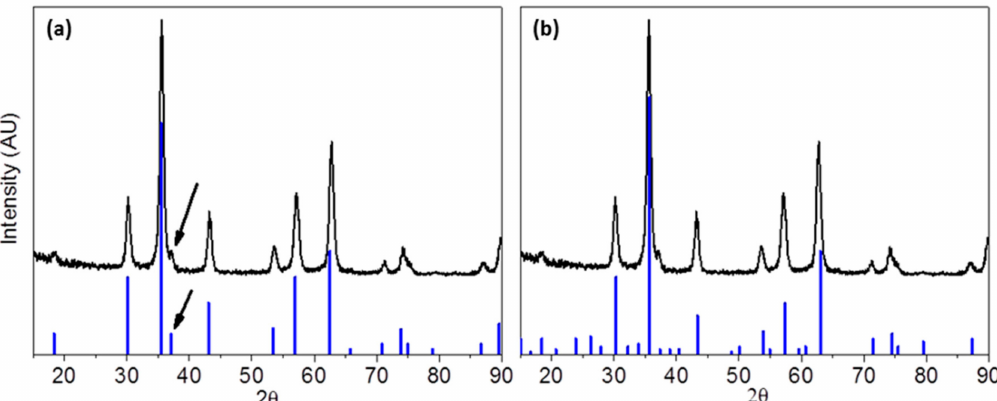
Figure 3. X-ray di ff raction (XRD) pattern of sample TD1 in comparison with the peaks of two iron oxides: ( a ) magnetite (PDF #19-0629) and ( b ) maghemite (PDF #25-1402). The arrow shows the presence of a peak that corresponds to